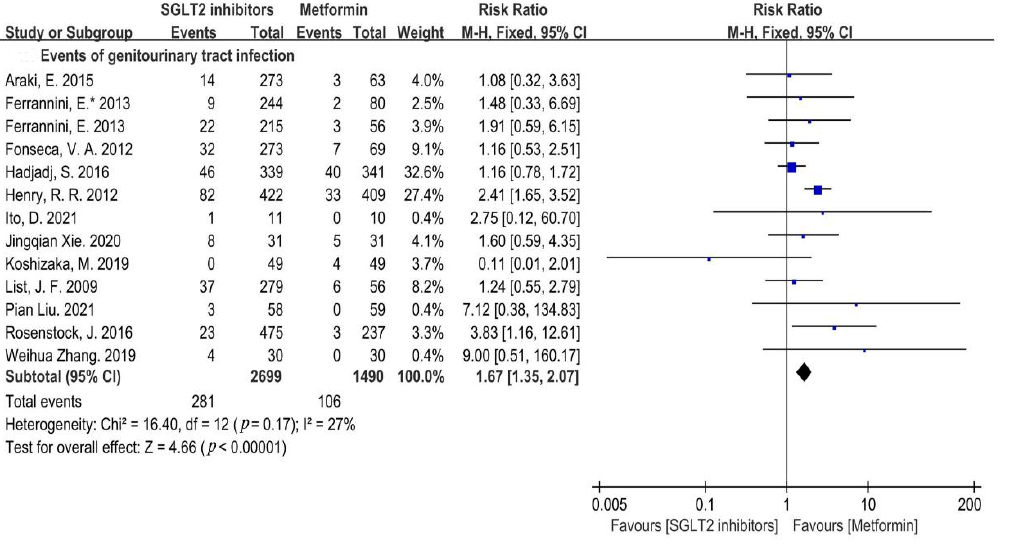
Figure 3 . Risk of genitourinary tract infections of SGLT2i compared with that of metformin [20 –